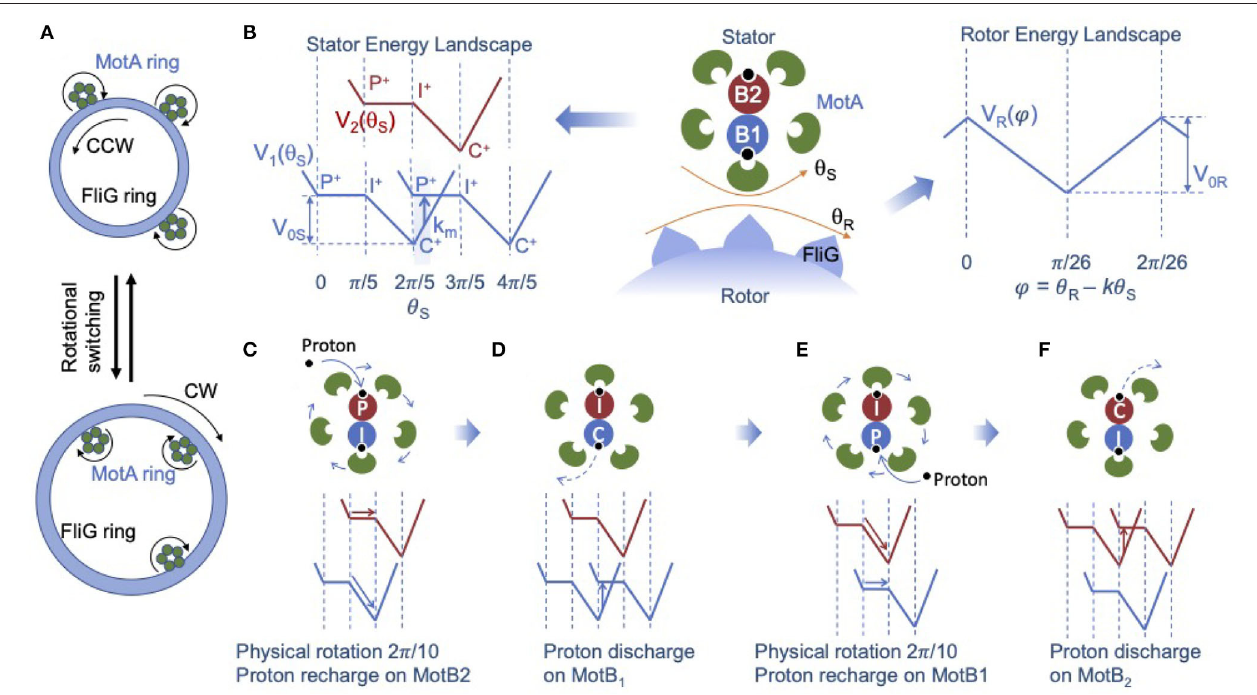
FIGURE 1 | A structure-informed model for the bacterial flagellar motor (BFM). (A) Illustration of the bidirectional rotation of the BFM. In counter-clovkwise (CCW) mode (top), the C- ring adapts a compact conformation, and the MotA ring on stator units contacts the FliG subunits on the outside of the C-ring. In the CW mode (bottom), the C-ring expands, and the MotA rings contact the FliG subunits on the inside of the C-ring. (B) Illustration of the two-rotating-ring model for the BFM (center panel). The stator energy landscape (left panel) shows the two interaction potentials between the MotA pentamer ring and the MotB dimer: V 1 ( θ S ) from MotB 1 (blue) and V 2 ( θ S ) from MotB 2 (red), which have the same shape but are shifted from each other by half a period 1θ S / 2 = 2 π/ 10. The blue and red energy landscapes are shifted vertically only for clarity. P and C stand for the two conformational states of MotB in which the proton acceptor residue faces the periplasm and the cytoplasm, respectively, and I stands for an intermediate state between P-state and C-state. The plus (or minus) superscript indicates the proton-bound (or proton-unbound) state. Transition (stepping) from one MotA-MotB interaction potential to another interaction potential occurs with a probability rate k m near the potential minimum (shaded region in the left panel), which is driven by the proton discharge-recharge chain reaction P + → P − → C − → C + . For brevity, only the initial and final states ( P + and C + ) are shown, and the intermediate discharged states C − and P − are omitted (see text for the full description). The rotor energy landscape (right panel) shows the interaction potential ( V R ) between MotA and FliG, which depends only on the scaled angle difference ϕ = θ R − k θ S . For simplicity, we used a piece-wise linear form for V 1,2 and V R . To the left of the P → I plateau in V 1,2 , a barrier is added to prevent back flow. The four stages of stator dynamics during one full power stroke as described in Equation 2 are illustrated in C-F. (C) Physical rotation of the MotA pentamer ring, which is driven dominantly by MotB 1 and proton recharge (the black dot) on MotB 2 . (D) Proton discharge on MotB 1 , which causes the transition of the MotA-MotB 1 interaction potential and effectively shifts V 1 (blue line) by one period ( 1θ S ). (E) Physical rotation of the MotA pentamer ring, which is driven dominantly by MotB 2 and proton recharge on MotB 1 . (F) Proton discharge on MotB 2 , which shifts the MotA-MotB 2 potential V 2 (red line) by one